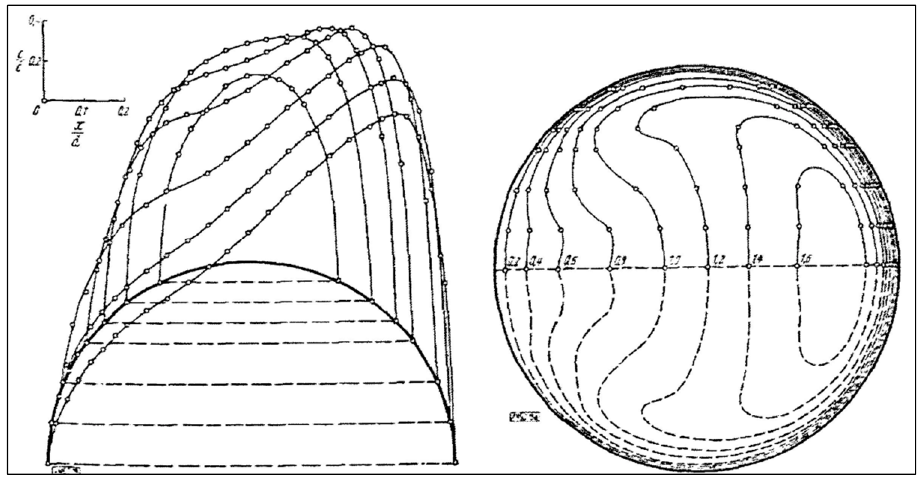
Figure 19. The flow pattern in helical coils with circular cross section according to Adler [30]. On the LHS the velocity distribution is shown. On the RHS the isotachs are shown with the typical kidney like shape.